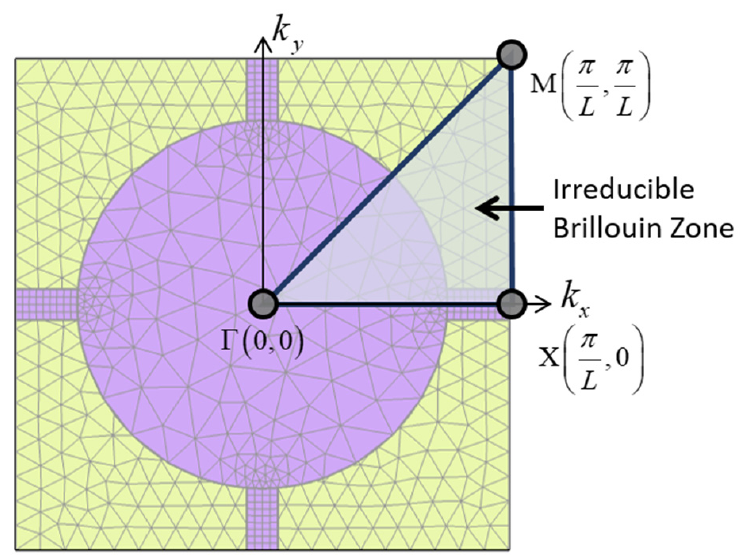
Figure 3. The irreducible Brillouin zone (IBZ) in the wave vector domain of a unit-cell structure. In this study, we considered the unit-cell structure in the form of a square of length L. Thus, the IBZ has the shape of a triangle made up of three points, Γ ( 0, 0 ) , X (cid:0) π (cid:1) M , π . The dispersion diagram of the interconnected metamaterial represents the set of L L iterative solutions for the eigenvalue problem in Equation (5) with the wave-vector domain. Figure 4 shows the dispersion diagram and Bloch modes calculated from stopband analysis for the unit structure of the interconnected metamaterial. The Bloch mode ω of the interconnected metamaterial is divided into the host structure dominant Bloch mode, ω host , which contributes to the transmission of the bending vibration of the host structure, and the resonator dominant Bloch mode, ω res , which does not directly contribute to the transmission of bending vibration. Therefore, the Bloch mode for the stopband which reduces the flexural vibration is determined by the host structure dominant Bloch mode, which is determined by the modal strain energy, as follows: